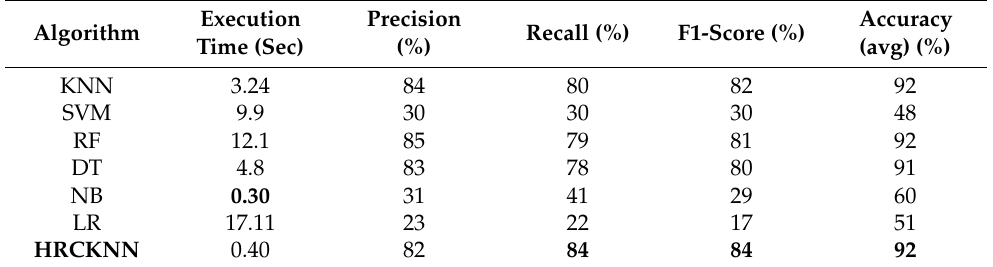
Table 5. Performance Comparison of Machine Learning Algorithms with